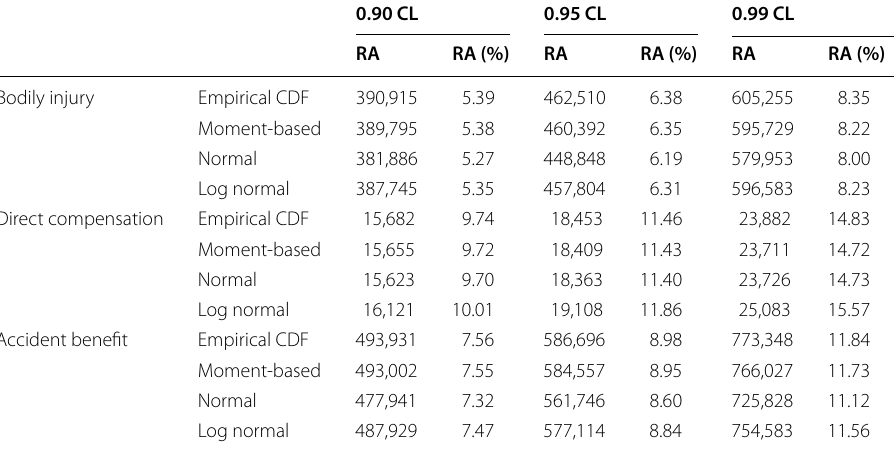
All RA amounts are in thousands in Canadian